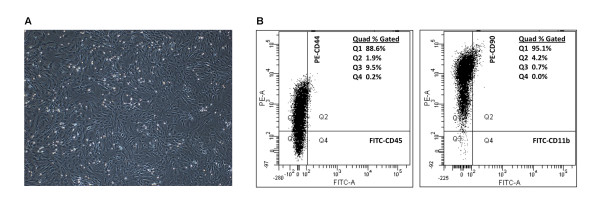
Morphology and characteristics of bone marrow derived rat MSCs at passage 2. (A) Rat MSCs maintained homogenous fibroblast-like appearance after adherent culture. (B) Cell surface markers were assessed using flow cytometry. Fluorescence intensity dotplots with specific antibodies (Ab); Phenotypes of MSCs labeled with Ab against PE-CD44 (with FITC-CD45 negative; left) and PE-CD90 (with FITC-CD11b negative; right). All experiments were performed in triplicate.